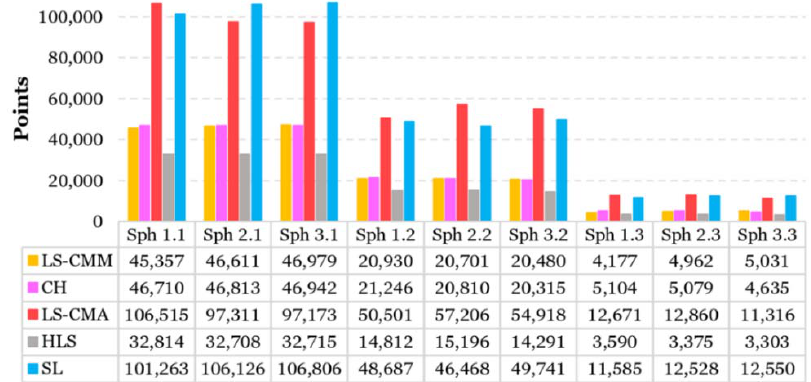
Figure 6. Number of points used in the creation of control spheres for the different optical measurement systems (OMSs).